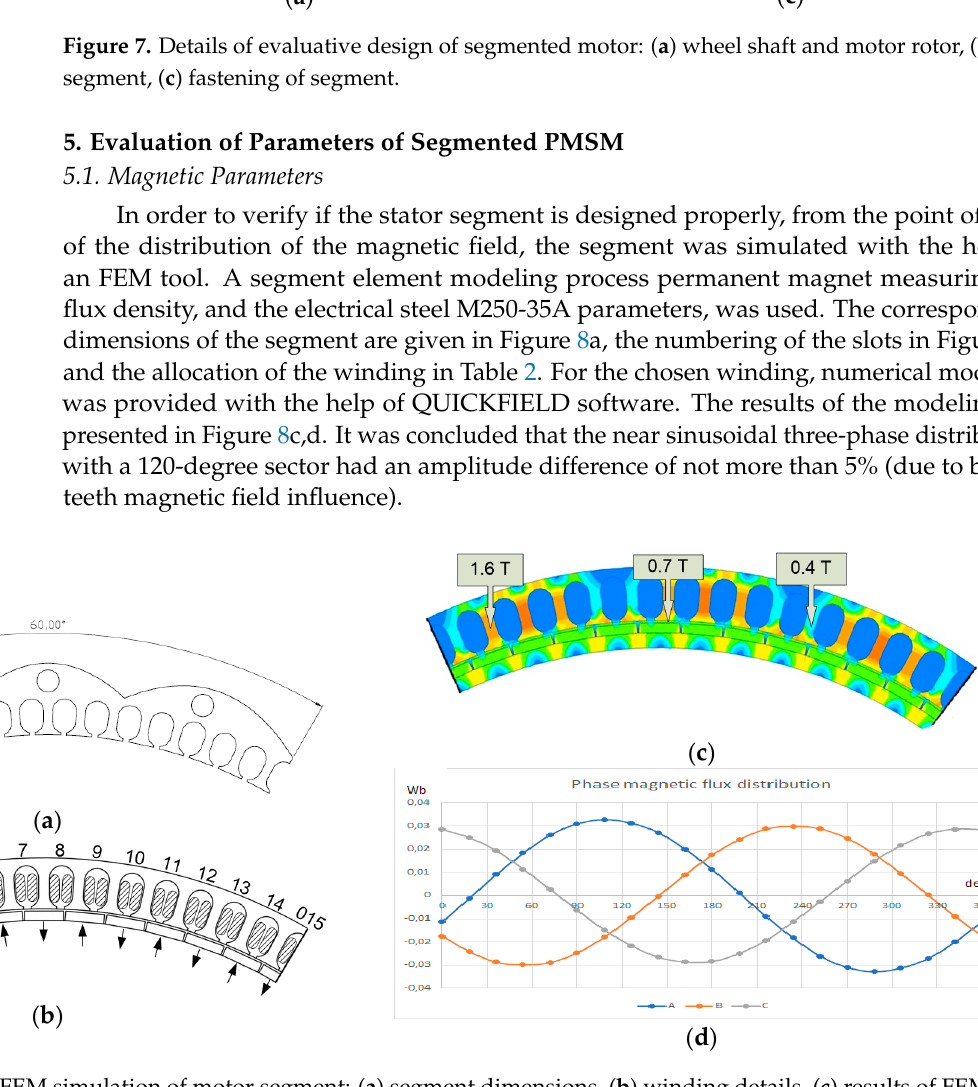
Figure 8. Model and FEM simulation of motor segment: ( a ) segment dimensions, ( b ) winding details, ( c ) results of FEM simulation, ( d ) phase magnetic flux distribution in one arc-shaped element. Table 2. Armature Winding Coil to Slot Arrangement.